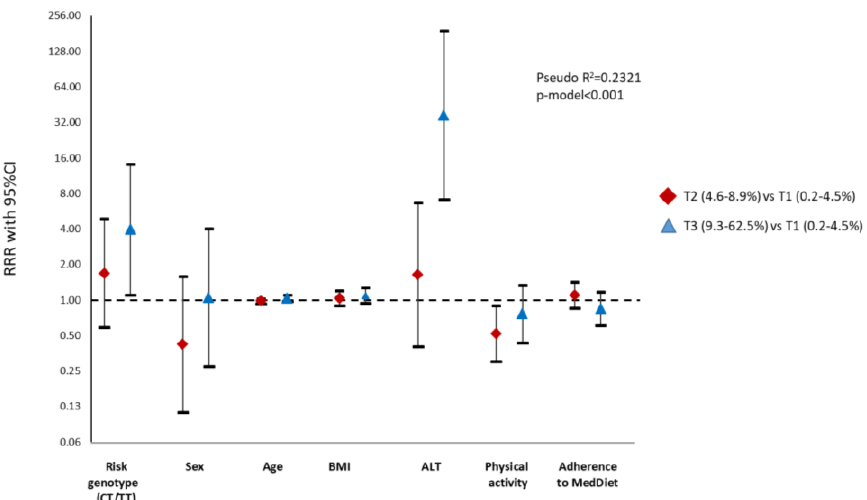
Figure 3. Graphical display of the Relative Risk Ratio (RRR) (95% confidence interval) of the multinomial logistic regression model with SH2B1 genotype as independent variable and liver fat content (tertiles) assessed by Magnetic Resonance Imaging (MRI) as a dependent variable. Notice that the y -axis is on a log scale. ALT, Alanine Aminotransferase; BMI, Body Mass Index.